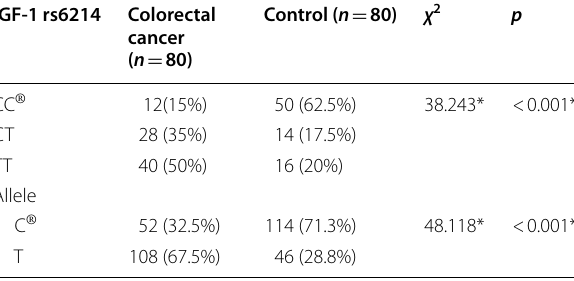
Table 2 Comparison between the two studied groups according to genotypes and alleles of IGFrs6214(C/T) polymorphism